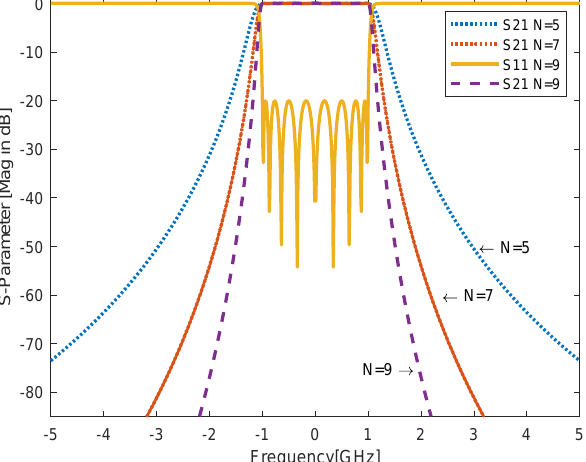
Figure 11. Alteration of CSRR rings width w parameter and its efffect on resonant frequency w = 2, 2.333, 2.666, and 3 mm; resonant frequency is shifted to the left as well as the bandwidth being decreased.